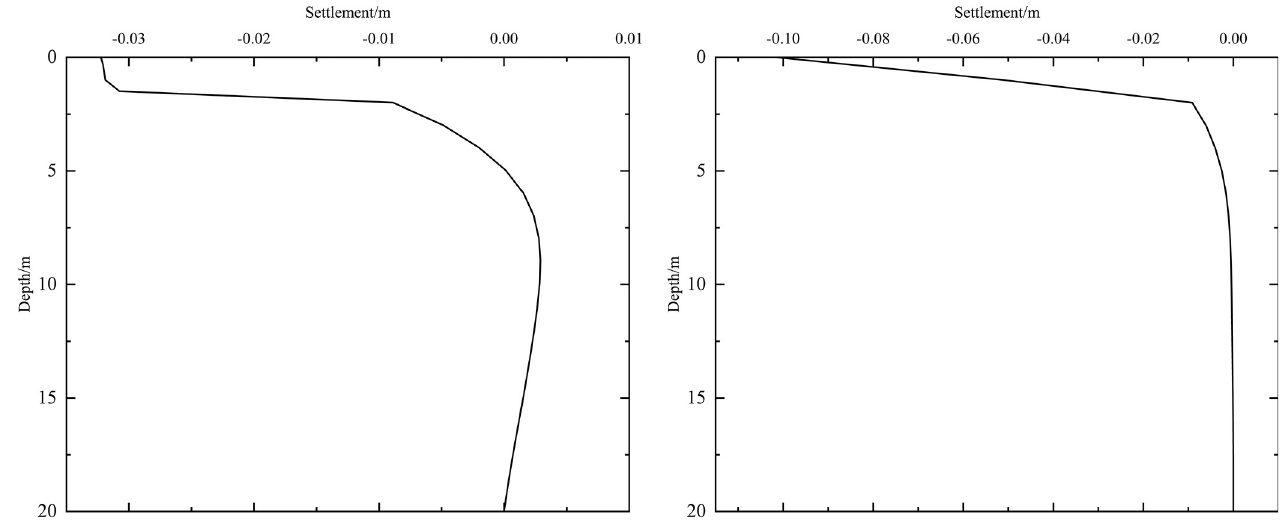
Fig 17. Settlement-depth curves under the static load of the aircraft after 10 years of operation at the (a) pavement center and (b) natural surface center.